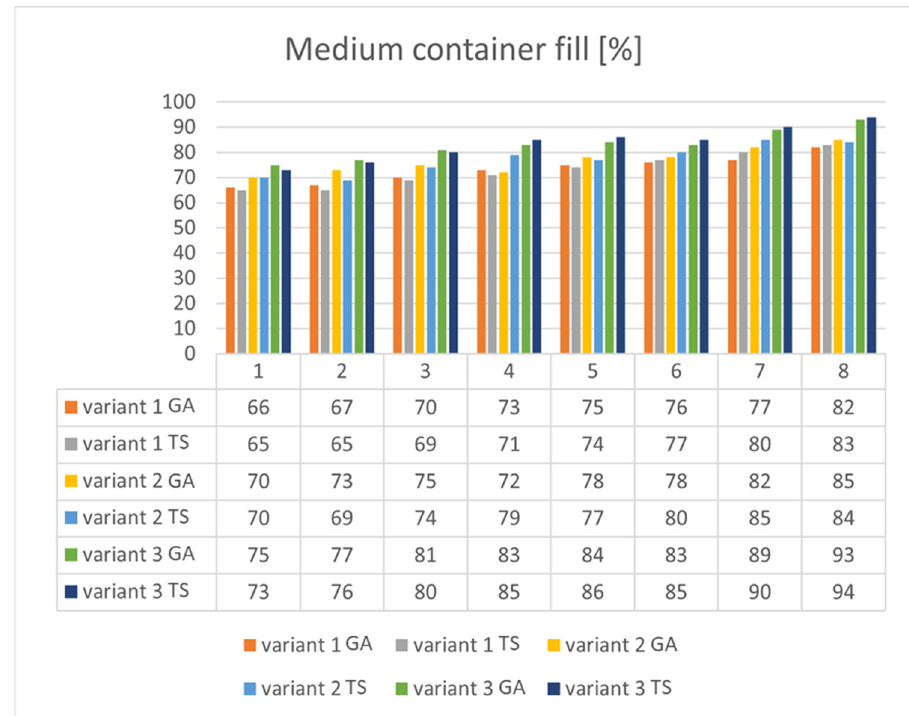
Figure 8. Simulation results of filling a medium container for various difficulty levels (each variant using both algorithms).